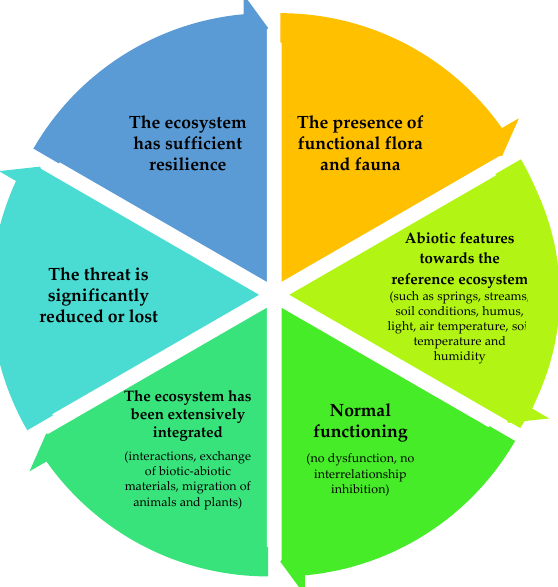
Figure 4. Characteristics of an ecosystem that has been successfully restored; (Source: Ministry of Forestry Regulation No. 48 of 2014).